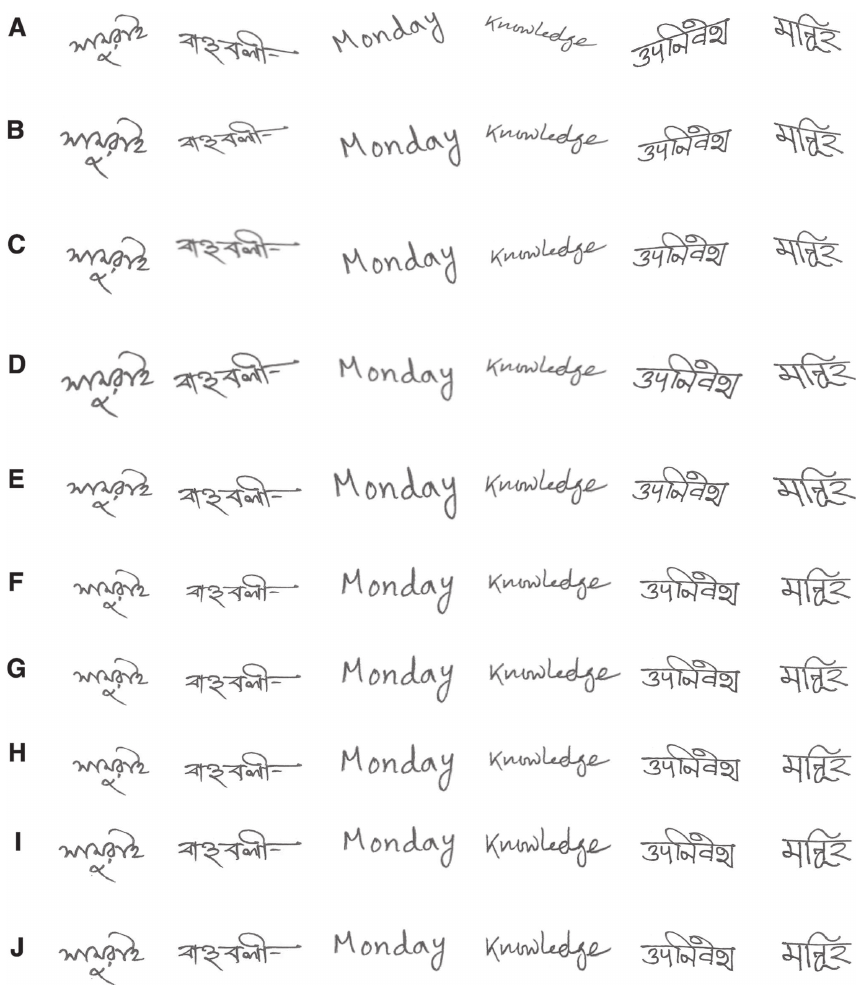
Figure 11: Each Row of the Figure Represents (A) Sample Words; Slope-Corrected Words by (B) Gupta and Chanda [11], (C) Malakar et al. [21], and (D) Okun et al. [25]; (E) Proposed Slope-Correction Approach; Slant-Corrected Words by (F) Pastor et al. [28], (G) Kavallieratou et al. [18], and (H) Papandreou and Gatos [27]; (I) Proposed Slant-Correction Approach; and (J) GT words.